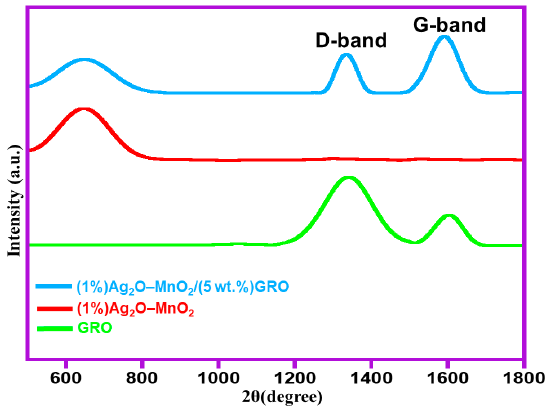
Figure 3. Raman spectra of GRO, (1%)Ag 2 O–MnO 2 , and (1%)Ag 2 O–MnO 2 / (5 wt.%)GRO.